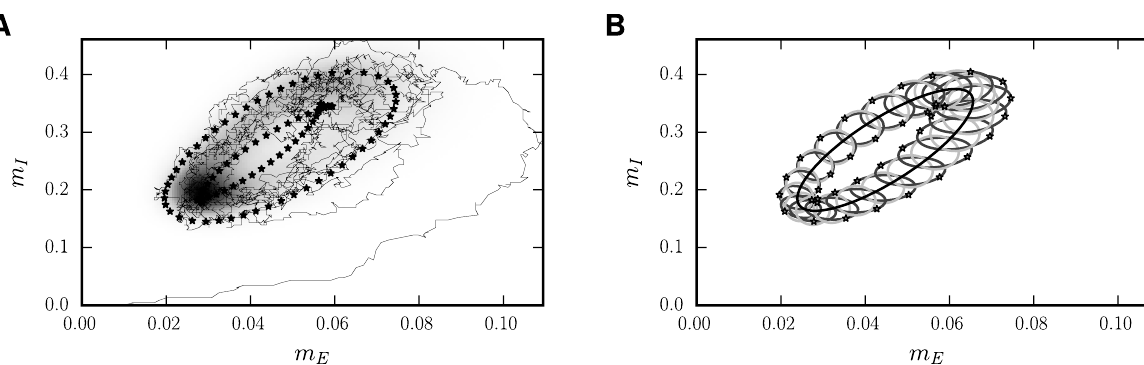
Fig 7. Distribution of population-averagedactivity of periodically driven E-I network. A Empirical density of populationactivity of the E-I network. Gray shadingindicatestime-averaged occupationof states. The thin mid gray curve is a sample of the binary dynamics of 10 periods after the start of the simulation. The black dots indicatethe σ -regionpredictedby the linear theory as describedby Eq (13) in the main text. B Limit cycle of the linear theory (black ellipse),together with error ellipsesstemming from the sum of covariances and variances(dark gray, slightly tilted) and representingsolely variances(light gray). The stars are at the same places as in A. Parameters are given in Table 1, only the perturbationstrength is increasedto h ext = 6 (noiselevel around σ E ’ 14, σ I ’ 23) for reasonsof readability (for this value the simulatedresults already show deviationsfrom the linear approximation as shown in Fig. D in S1 Text). The perturbing frequencyis chosen to be f = 80